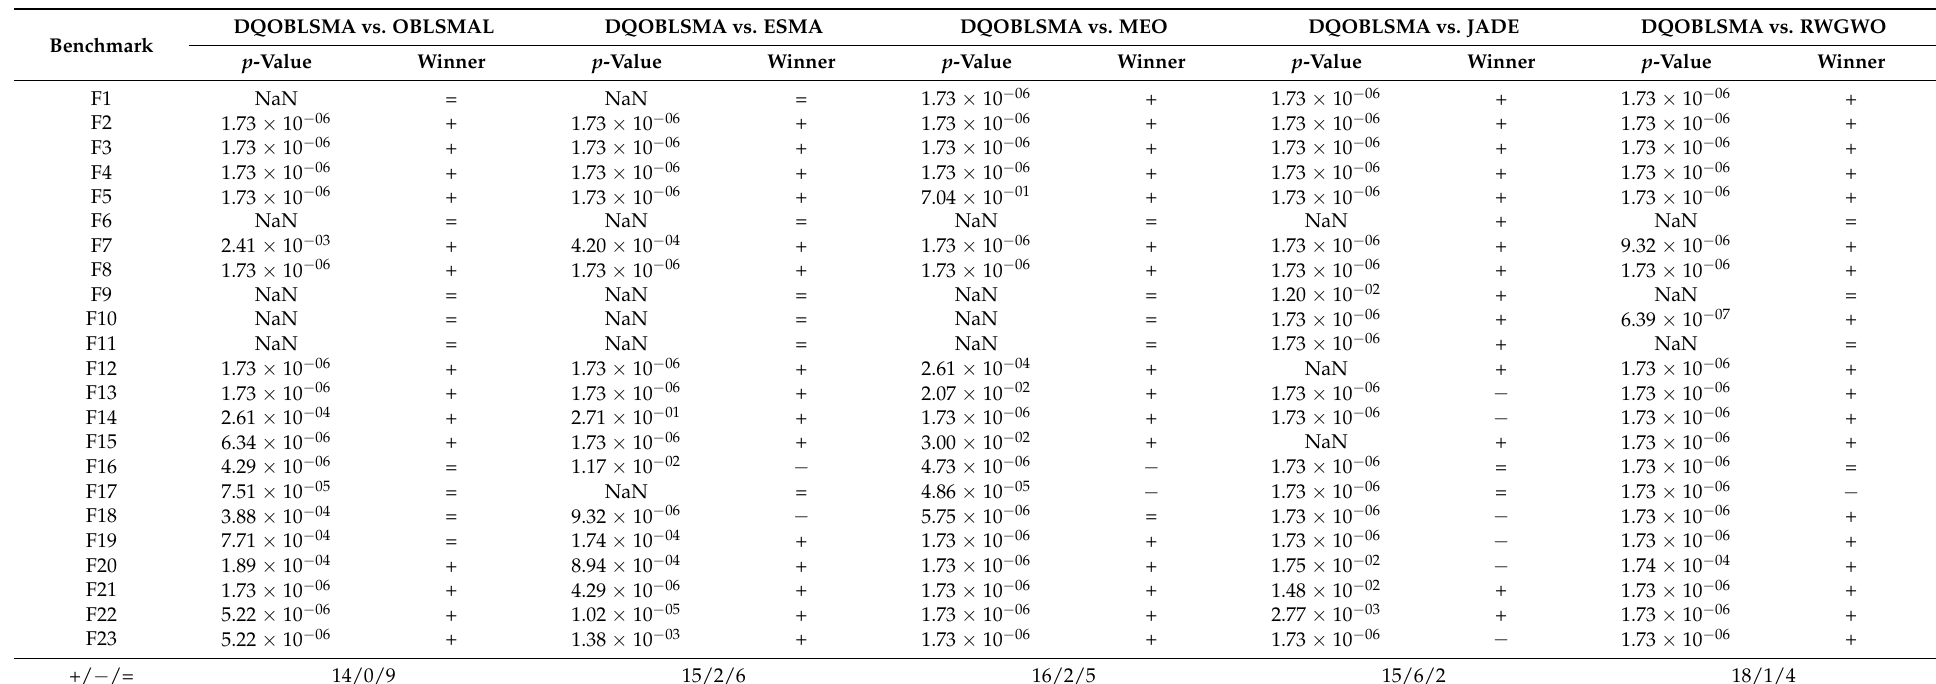
Table 9. Test statistical results of Wilcoxon’s rank-sum